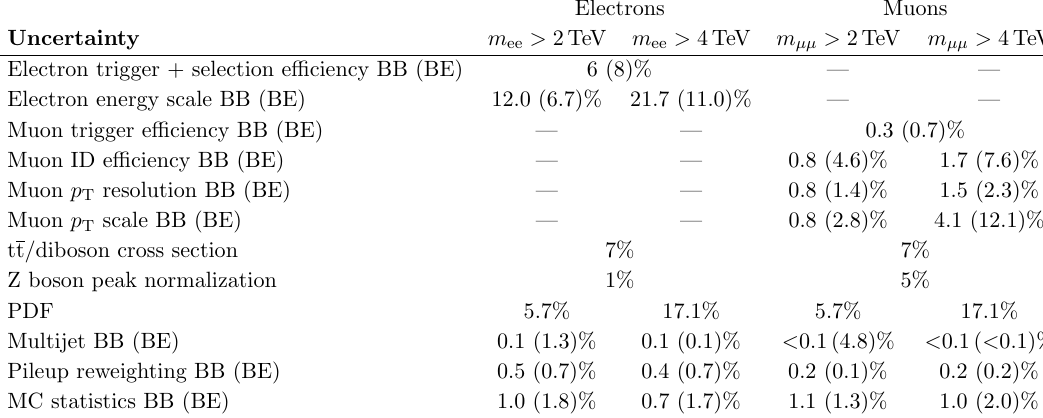
Table 1 . Systematic uncertainties in the predicted SM yields for the electron and the muon channels, for two dilepton mass thresholds. Where noted, uncertainties are provided separately for events where both leptons are in the barrel region (BB), or where at least one of the leptons is in the endcap region (BE). Uncertainties that are mass-dependent a(cid:11)ect both the event yield and the shape of the invariant mass distribution. The systematic uncertainties in the signal yields are largely the same as for the background, with a few exceptions as discussed in the